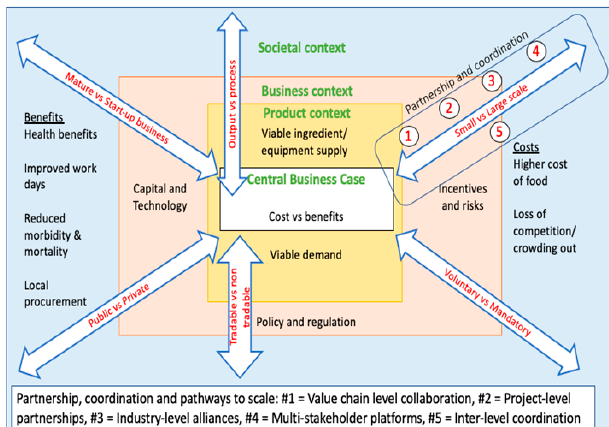
Figure 1. Business viability factors.